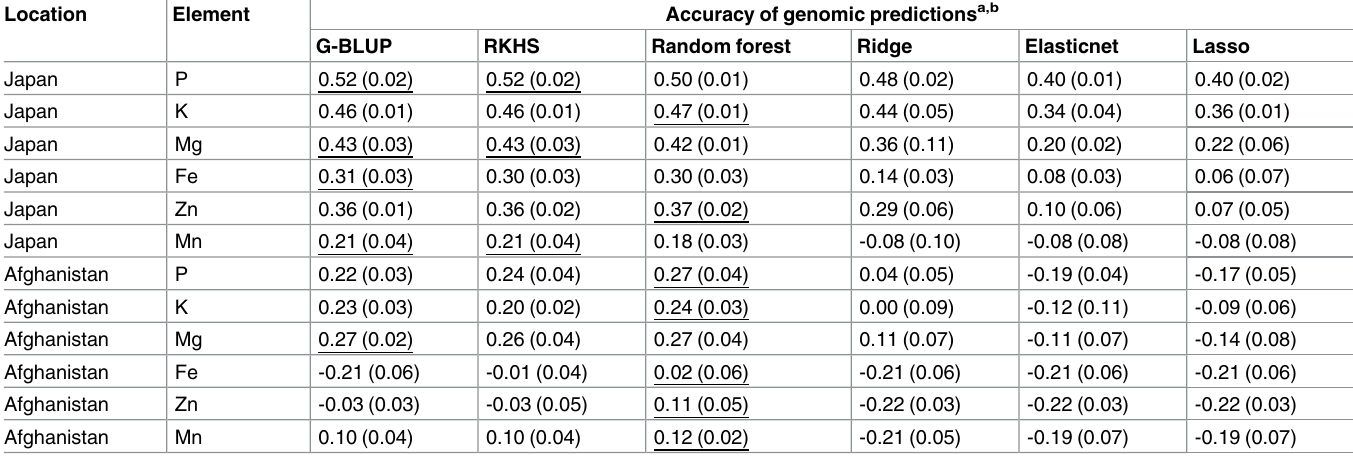
Table 3. Genomic predictions of elemental contents from various